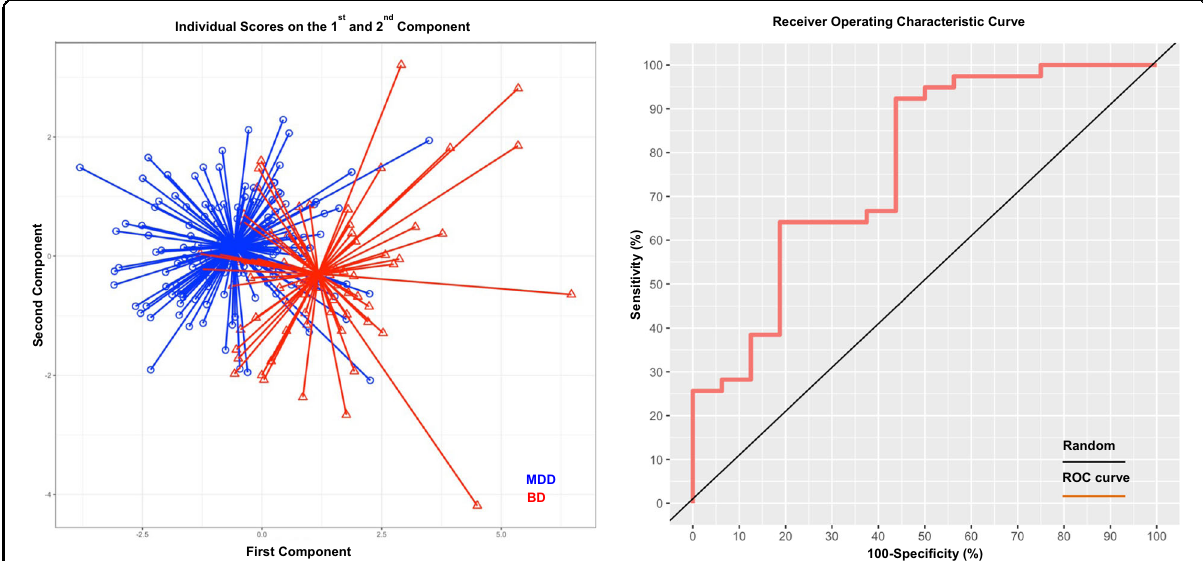
Fig. 1 Sparse partial least squares discriminant analysis (s-PLS-DA) of clinical features differentiating bipolar disorder (BD) from major depressive disorder (MDD). Left: Two components differentiated BD from MDD. The star plot shows their centroid. The individual patient score on these components are presented as lines radiating from the centroid. Lines representing patients with MDD are shown in blue and lines representing patients with BD are shown in red. The variable weights for each component are presented in Supplementary Table S6. Right: The receiver operating characteristic curve derived from the s-PLS-DA differentiating BD from MDD based on the test samples; area under the curve (AUC) = 0.73, P = 0.001 (additional details in Supplementary Fig. S3A,